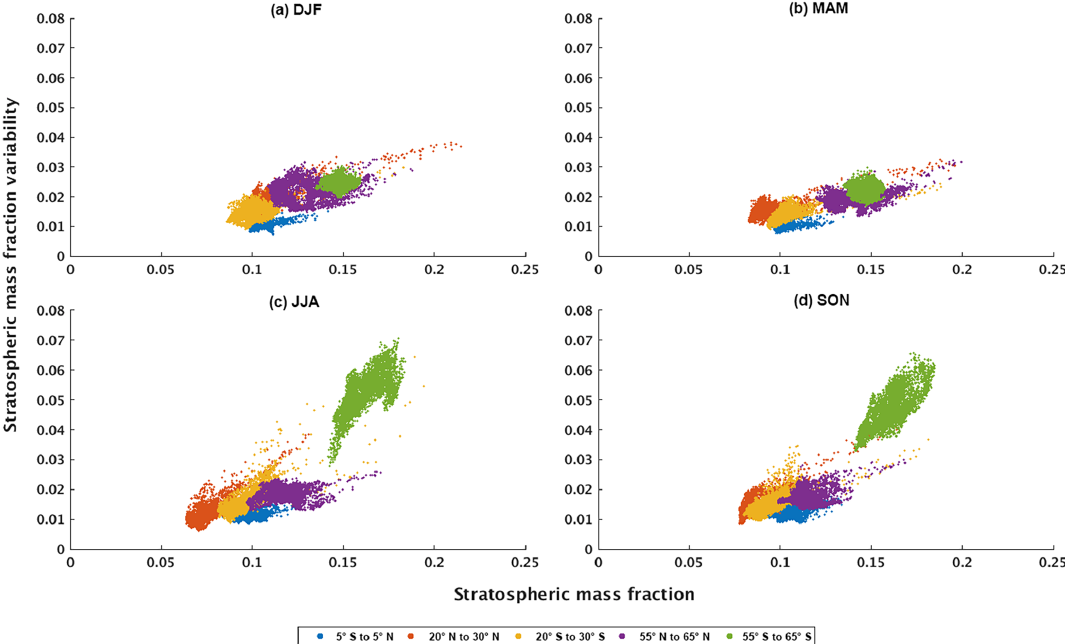
Figure 4. Scatterplots showing the CH 4 stratospheric column mass fraction ( f str ) against CH 4 stratospheric column mass fraction variability ( σ str ) for (a) December–February, (b) March–May, (c) June–August and (d) September–November months of 2010. The colour shading indicates different latitude